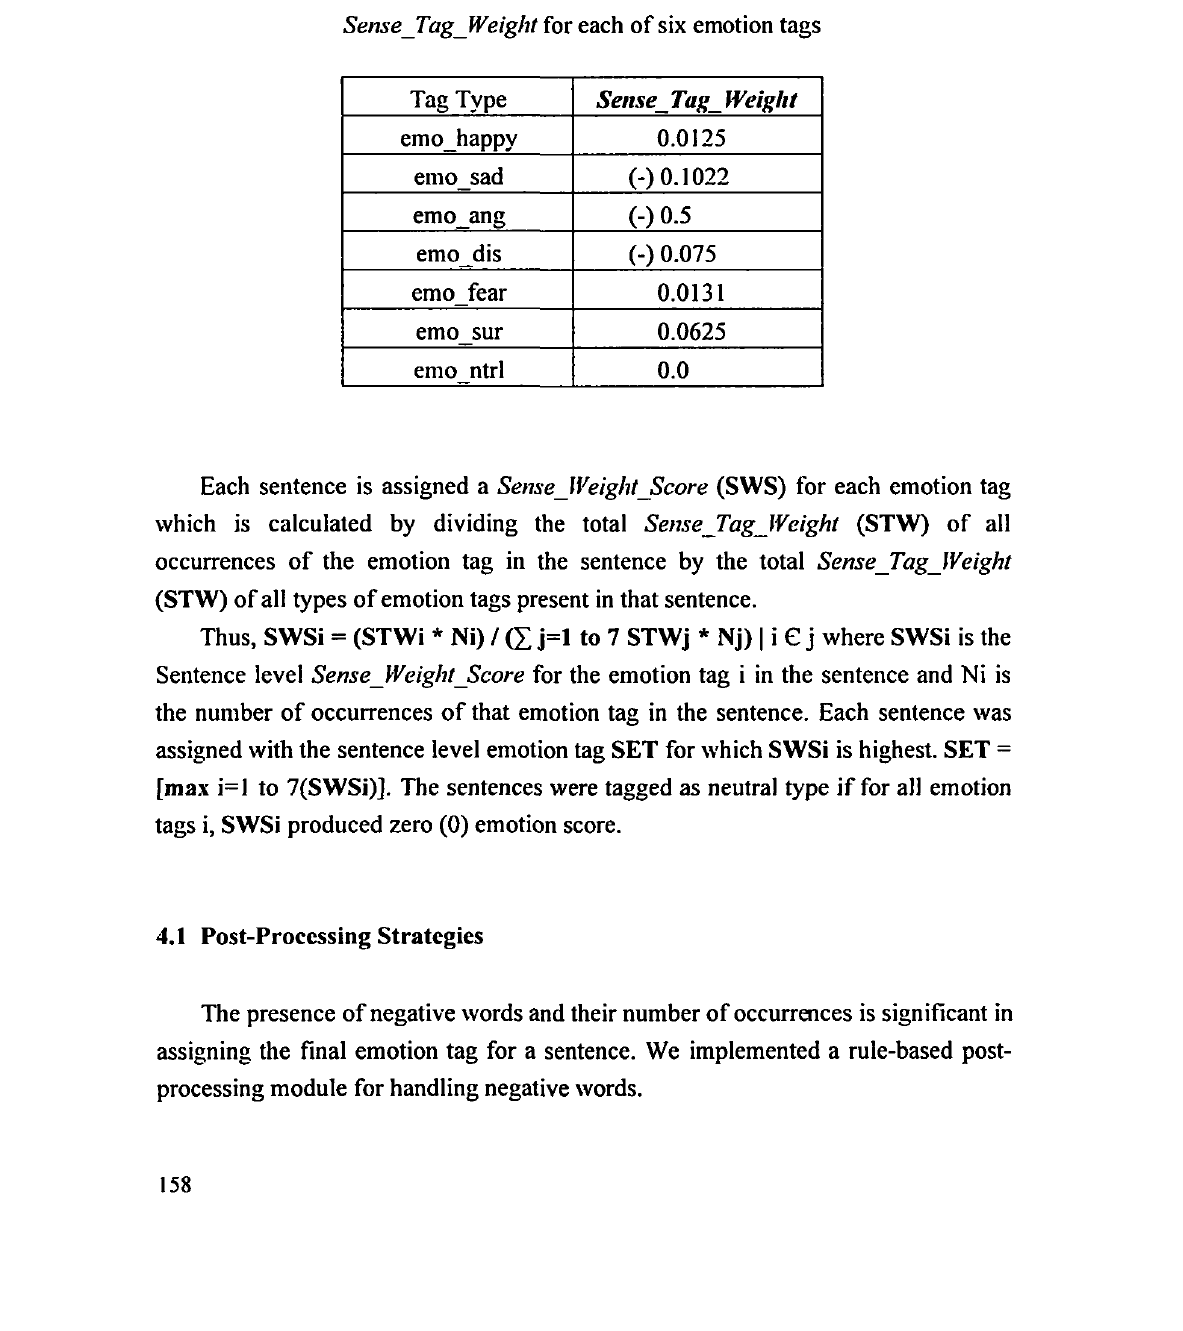
Sense_Tag_Weight for each of six emotion